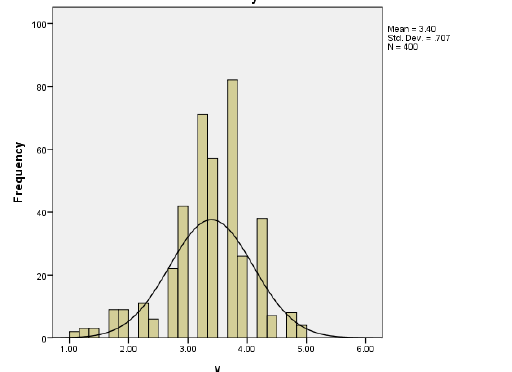
Fig. 1. Distribution of residuals of tax